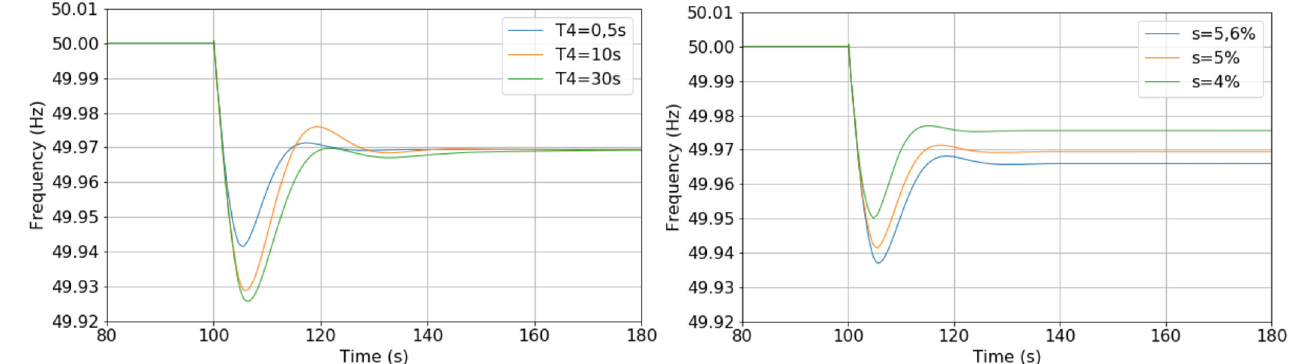
Fig. 5. Frequency response after a 2% load increase as function of time constant (left) and droop